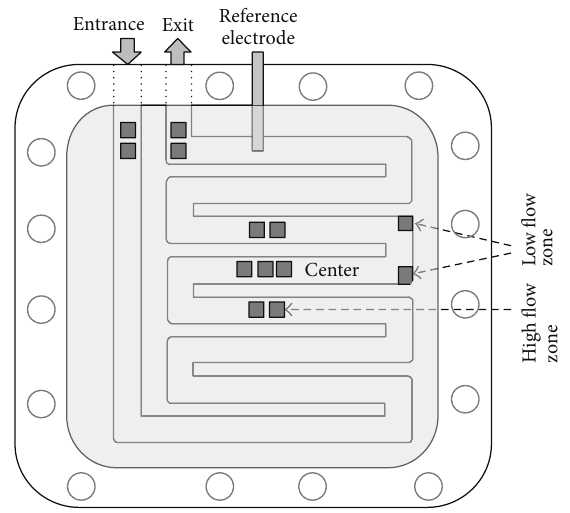
Figure 1: Schematic representation of the cathode chamber with the locationsofthesamples(darkgreysquares)usedformicrobiological analysis. Samples were about 1 × 1cm 2 . The high flow zone is where thecathodewasincontactwiththestraightpartoftheflowchannels, while the low flow zone is where the cathode was located in a dead zone. The graphite felt electrode (light grey) was placed between two supportive flow channel plates. The total projected surface area of cathode was 361 cm 2 , while the effective geometric channel surface area was 290cm 2